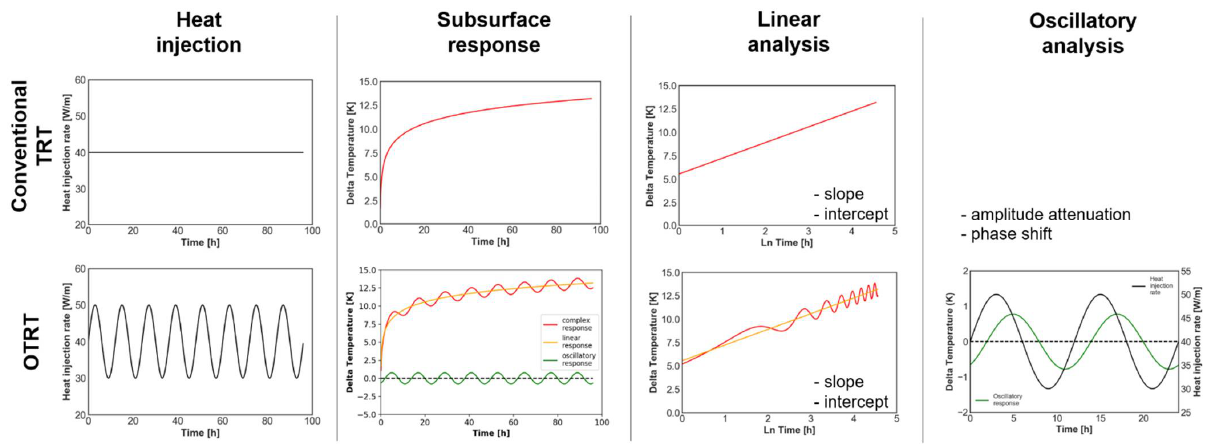
Figure 1. Comparison between conventional and oscillatory TRT (reprint with permission [17]).